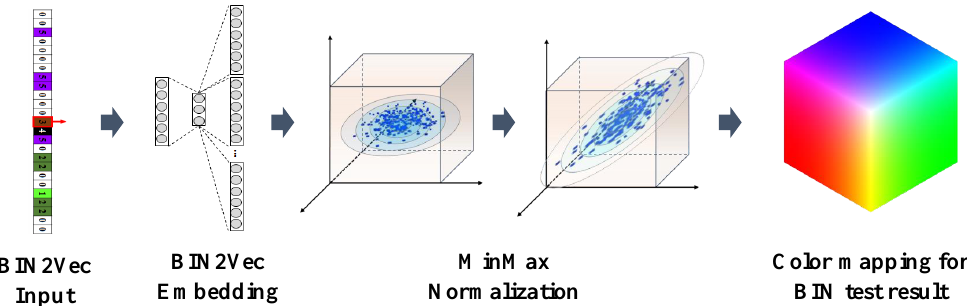
Figure 6. Bin code RGB color mapping framework based on